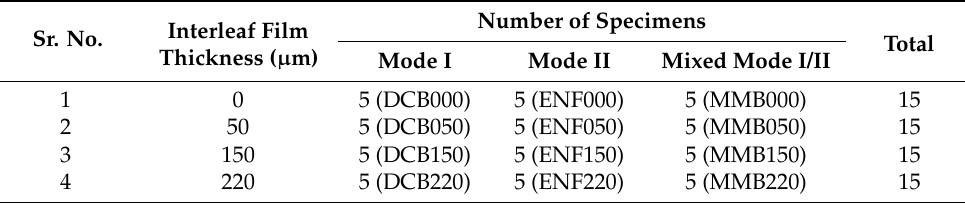
Table 2. Specimen nomenclature based on the interleaf film